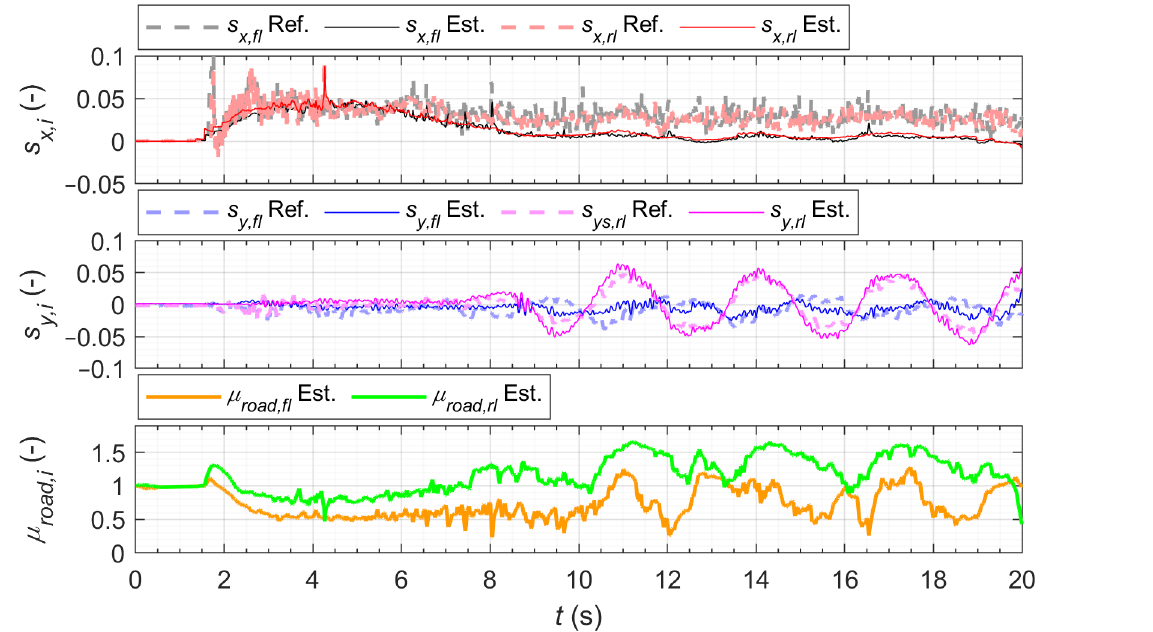
Figure 10. Test data—Slalom maneuver on a dry road surface: measured and estimated tire slip for front left and rear left wheels as well as estimated tire model adaption